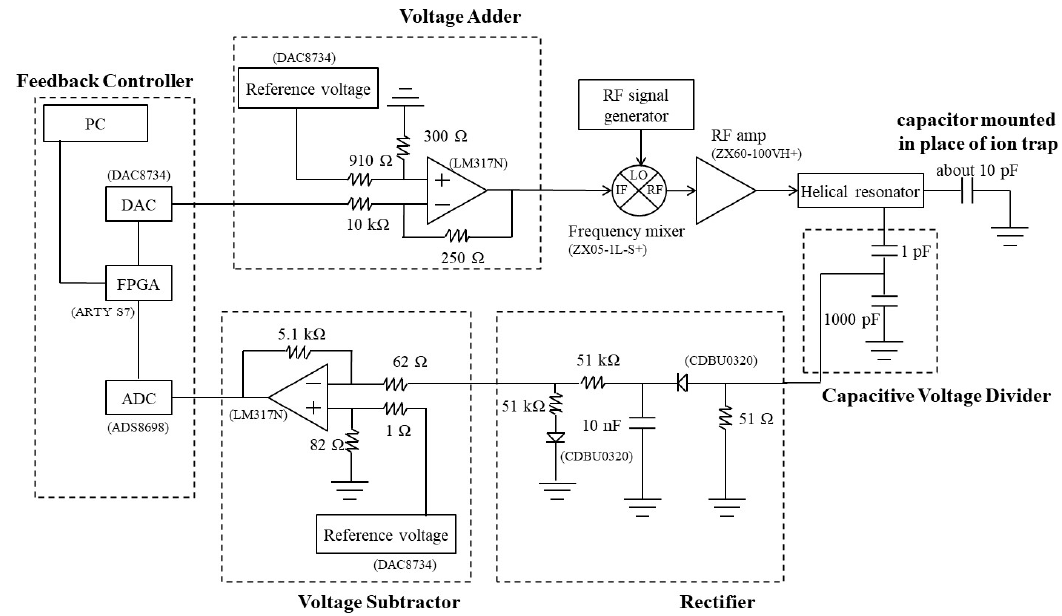
Figure 3. A block diagram of the closed-loop feedback control system for reducing the fluctuation of the amplitude of the RF signal, using the field-programmable gate array (FPGA)-based feedback controller.